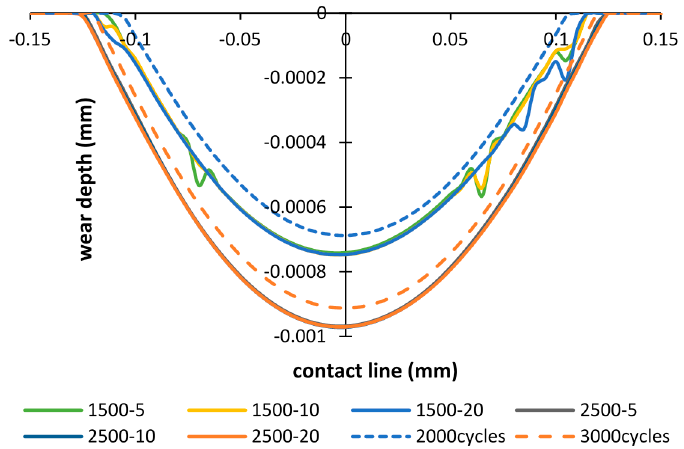
Figure 12. Wear scars after 2000 cycles and 3000 cycles: importing time = 1500, 2500 cycles and layer thickness = 5 µm, 10 µm, 20 µm.